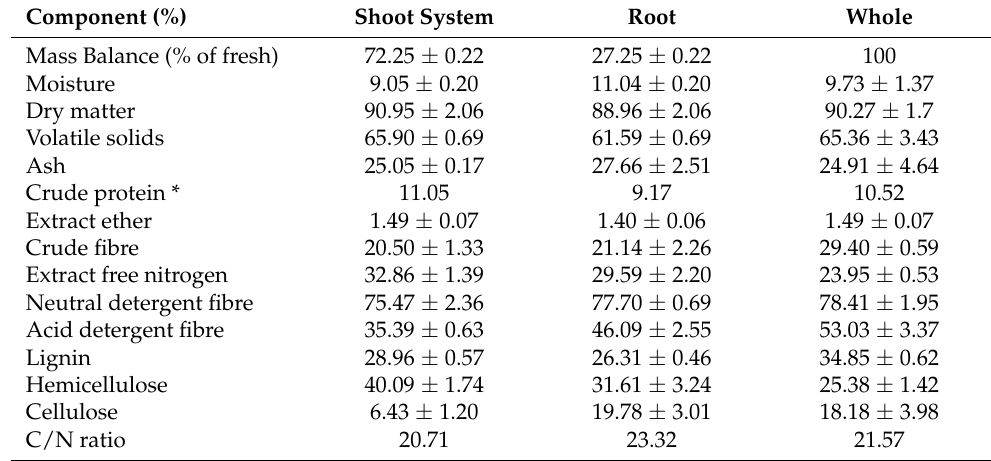
Table 3. Chemical composition of PS meal. Component